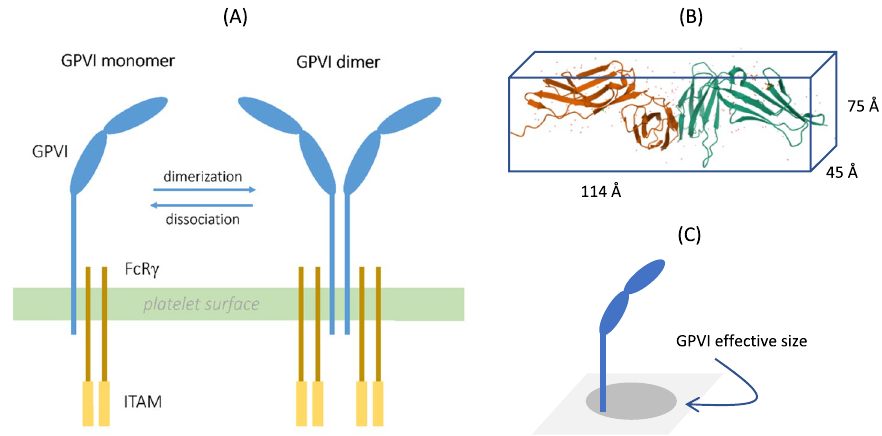
Figure 1. Structure and dimerisation of platelet GPVI receptors. ( A ) The extracellular domain of monomeric GPVI on platelets comprises of two IgG domains and a connection to the transmembrane domain (blue). The GPVI protein is stably connected to two chains of the FcR γ-chain, forming ITAM-containing signalling domains. Monomers of GPVI can dimerise with other monomers (dimerisation), a process that is reversible (dissociation). Adapted from Induruwa et al. (2016) 27 . ( B ) Crystal structure of human platelet GPVI. Image taken from RCSB PDB (rcsb.org), annotation PDB ID 2GI723. ( C ) Projected illustration of GPVI as a transmembrane protein with an assigned effective area in two